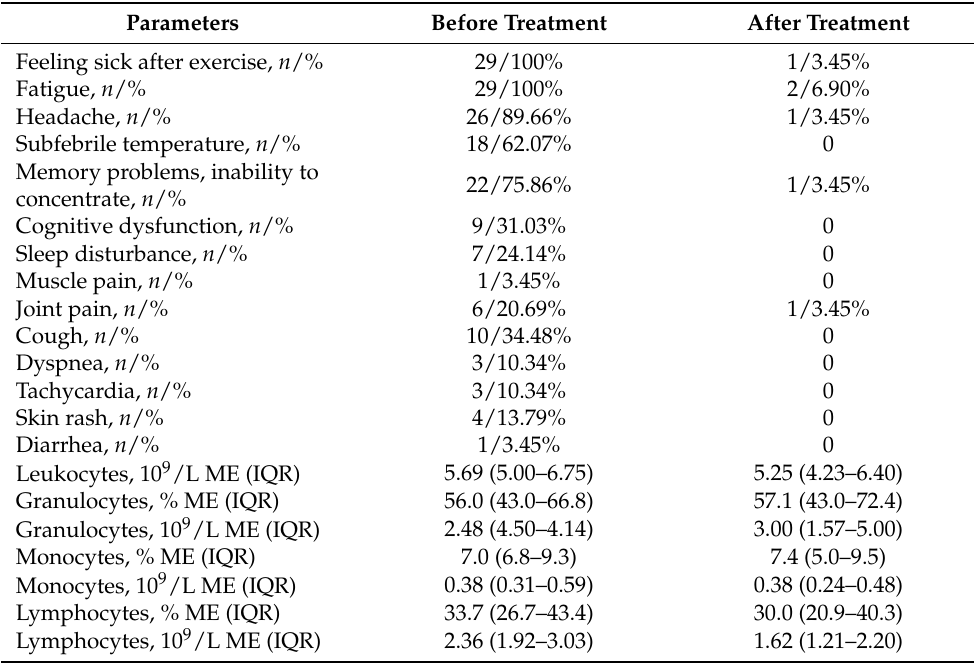
Quantitative data are presented by the median and interquartile ranges (median (IQR)). When assessing the NK cell level in patients with post-COVID syndrome, it was found that before the onset of rhIL-2 treatment, the percentage and absolute level of NK cells was reduced compared to the control group; after treatment, the number of cells was restored to the level matching that of control magnitude (Figure 1).